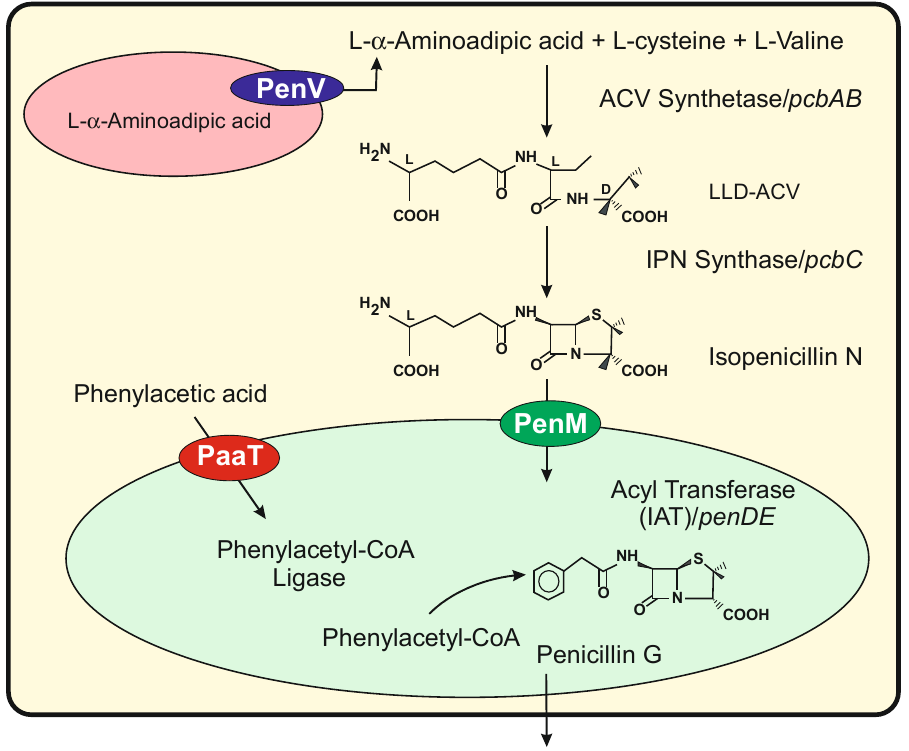
Figure 1. Biosynthetic pathway of benzylpenicillin in P. chrysogenum, indicating the subcellular location of the different enzymes and intermediates. A vacuole is shown in pink color, and the PenV transporter in the vacuole membrane is highlighted in a black ellipse. A peroxisome is shown in green color, and the transporters PaaT and PenM are indicated in red and green ellipses, respectively.